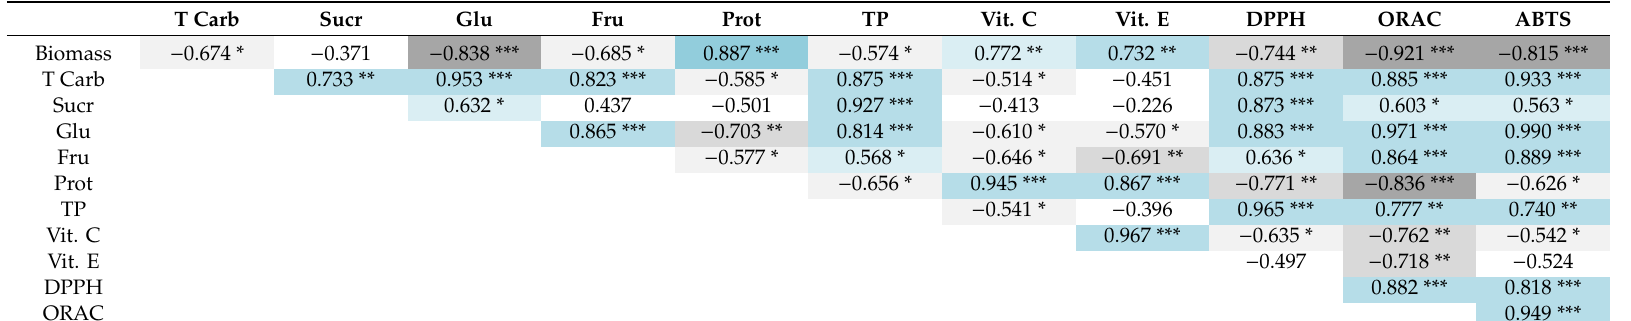
Table 5. Correlation matrix for the chemical